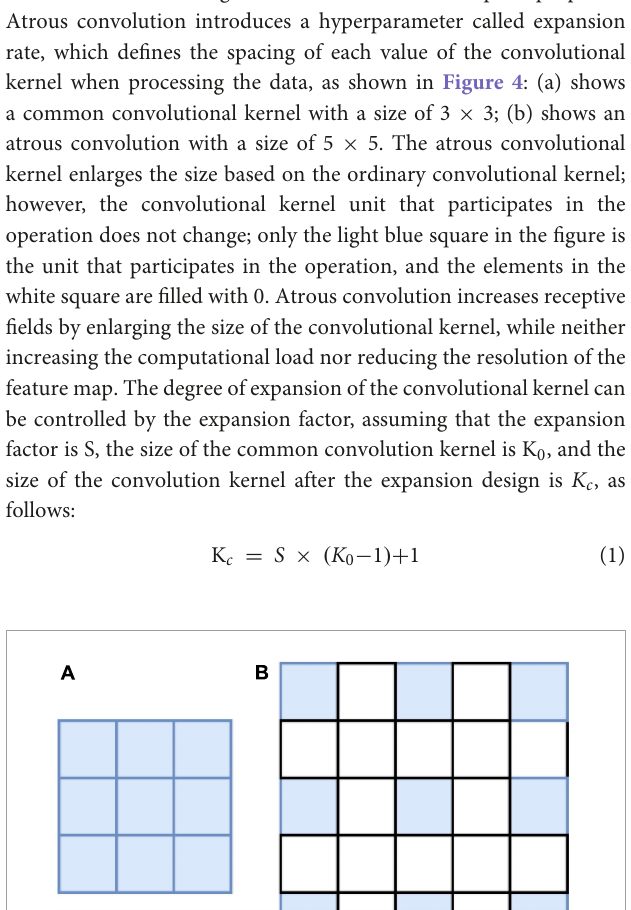
fields while maintaining the size of the feature maps is proposed.